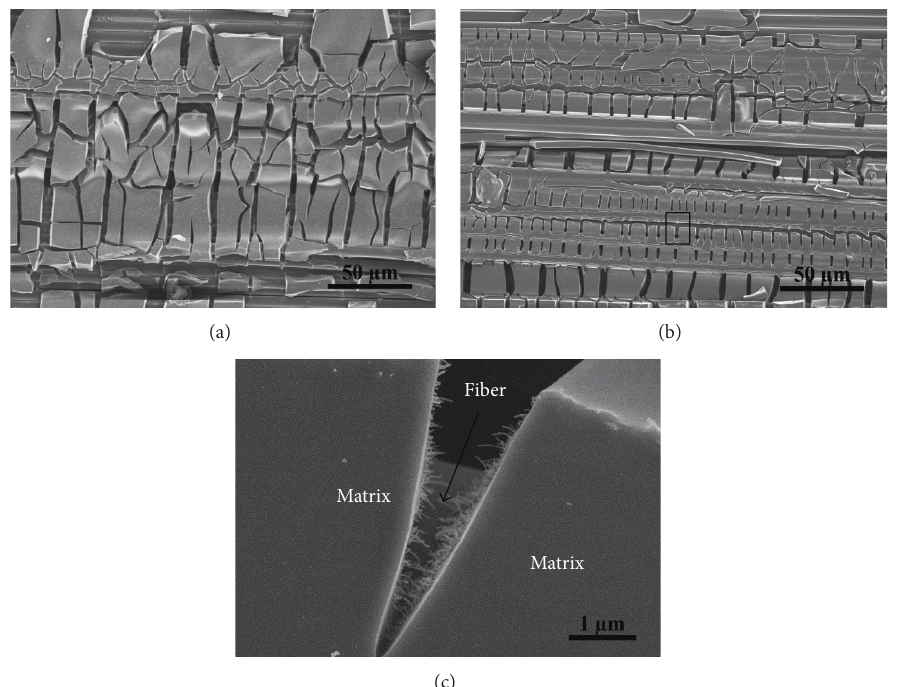
Figure 2: SEM images of the matrix morphologies on fibers after the first cycle of PIP of (a) C f /SiC, (b) C f /1%CNTs/SiC, and (c) magnifying image of the crack in the composite of C f /1%CNTs/SiC.